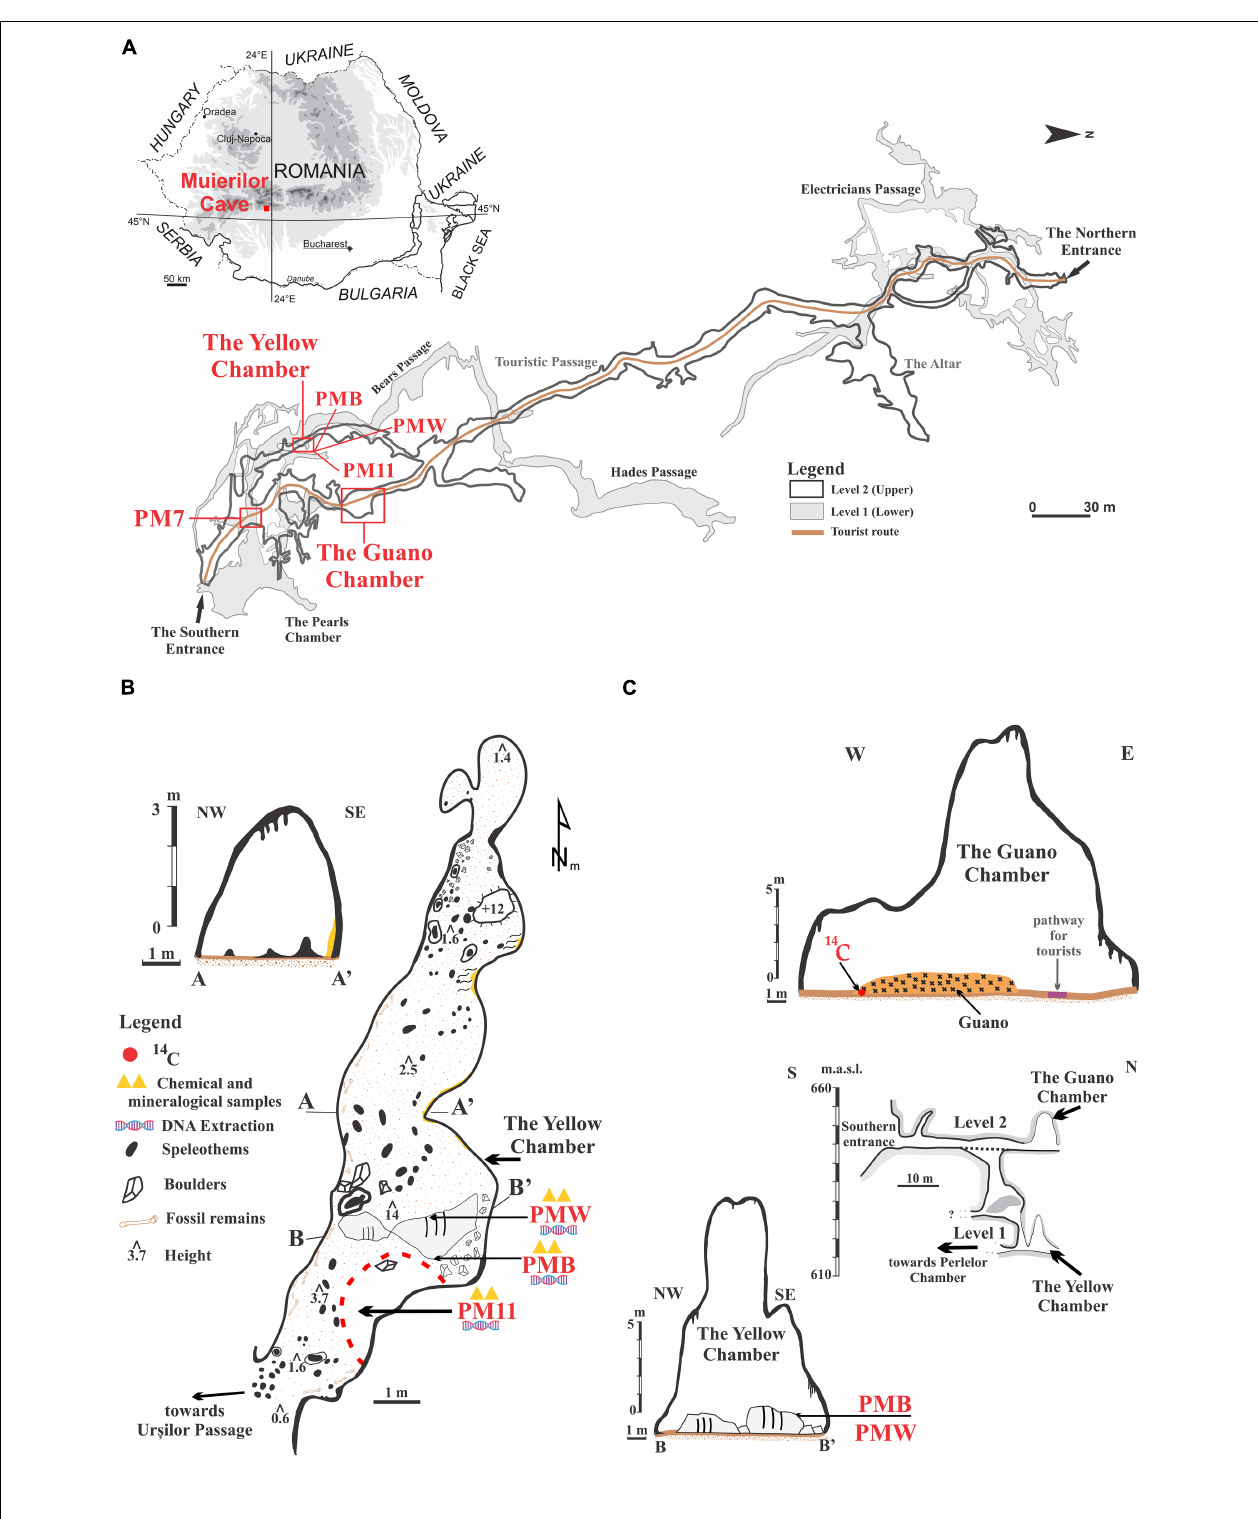
FIGURE 1 | Location of the sampling sites in Muierilor Cave and the country’s position in south-eastern Europe ( A , cave map courtesy of Grigore Stelian); (B) The Yellow Chamber with the sampling locations; (C) The Guano Chamber profile, with the position for the 14 C sample, and the southern profile of the cave showing the overlapping of the Guano Chamber and the Yellow Chamber profile with the sampling